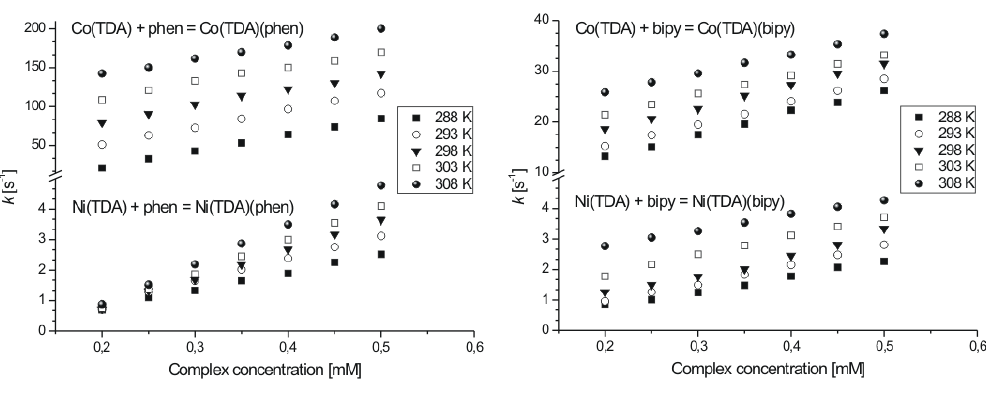
Figure 4 : The rate constant k (s -1 ) of the substitution reactions versus the concentration of the binary complex and the temperature for the systems under